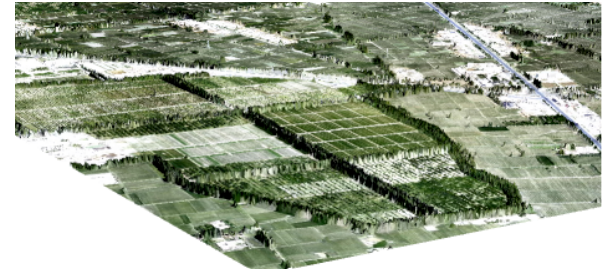
Figure 2: example of 3D rendering of the South-West part of the Yingke area obtained by combination of the LIDAR Digital Surface Model and the high resolution image simultaneously acquired by the CCD camera installed together with the LiteMapper 5600.